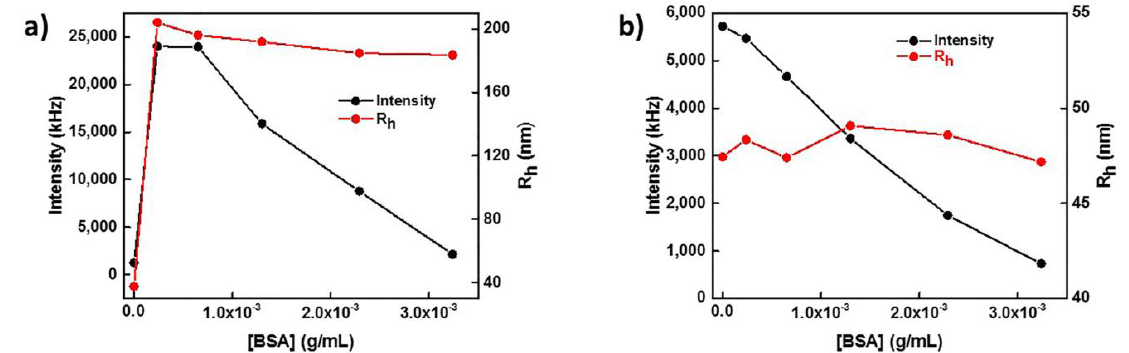
Figure 10. R h and scattered intensity as a function of BSA concentration for PLMA 22 - b -POEGMA 58 ( a ) and PLMA 22 - b -POEGMA 58 /10% NPs/20% IND ( b ) mixed nanostructures in